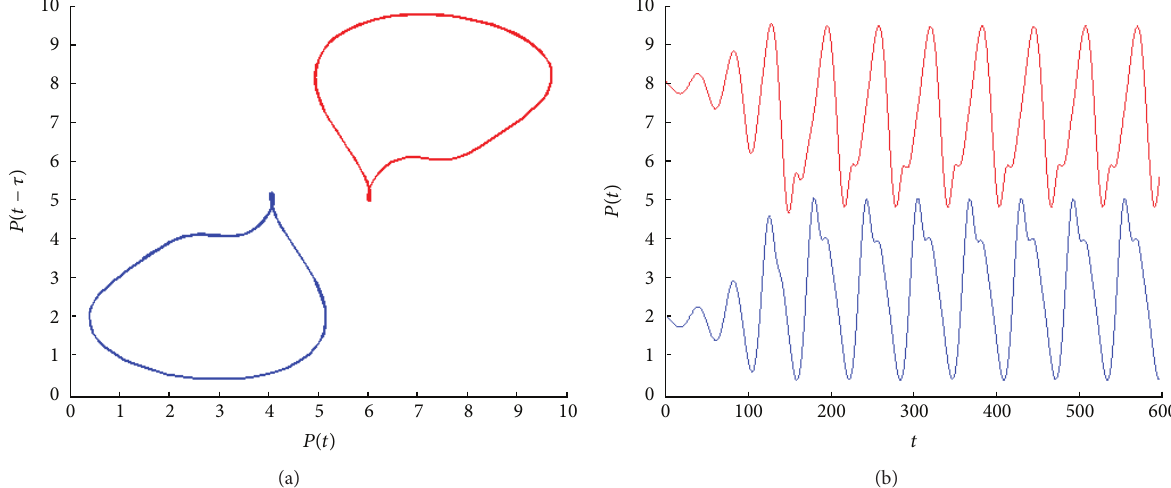
Figure 3: 𝜏 = 12 . (a) Two attracting closed invariant curves. (b) Corresponding time series with two local maxima and